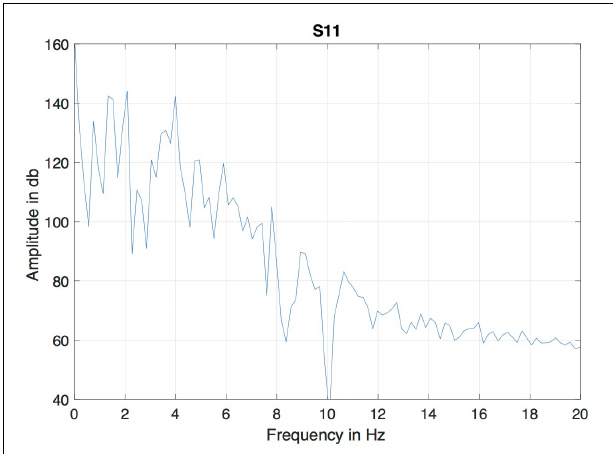
FIGURE 1 | Magnitude spectrum of the vertical position of T1 (marker nearest the tongue tip) for the test sentence produced by of the speaker